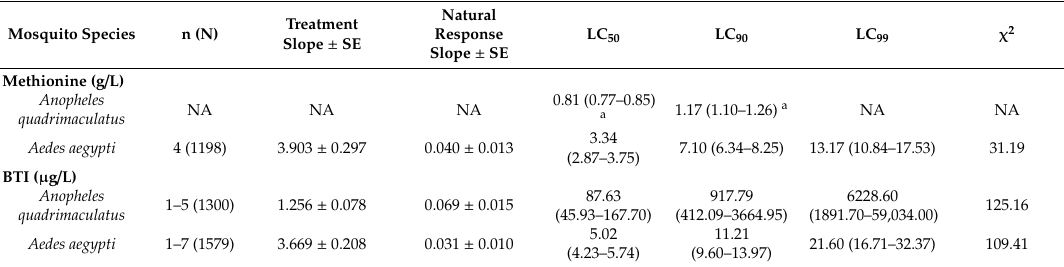
LC values with 95% inverse confidence intervals in parentheses. Chi-squared ( χ 2 ) values are listed. NA = not available. n = number of replicates. N = number of mosquitoes. a data extracted from Weeks et al. [19] and units